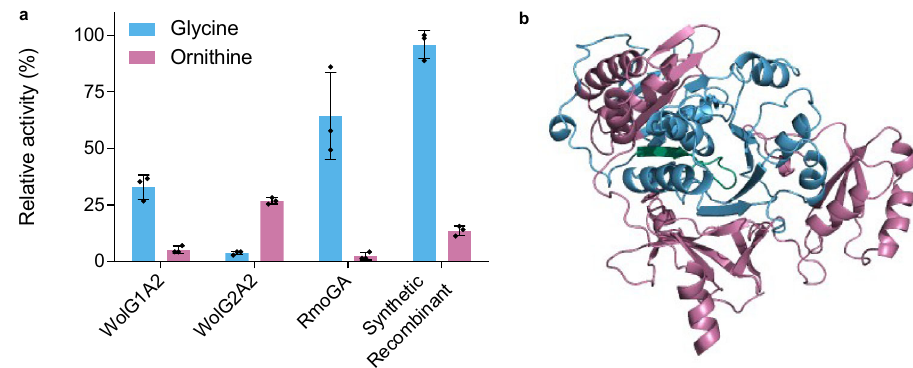
Fig. 5 Substrate speci fi cities of wild-type and recombinant adenylation domains. a Relative activities of adenylation domains as determined by hydroxylamine trapping assays 47 . Each amino acid and enzyme combination was tested in triplicate ( n = 3); the mean value was calculated and the standard deviation is shown. b Structural homology model of the synthetic recombinant adenylation domain. The model is colour-coded depending on the origin of the peptide sequence, pink for WolG2A2 and blue for RmoGA. The P-loop is highlighted